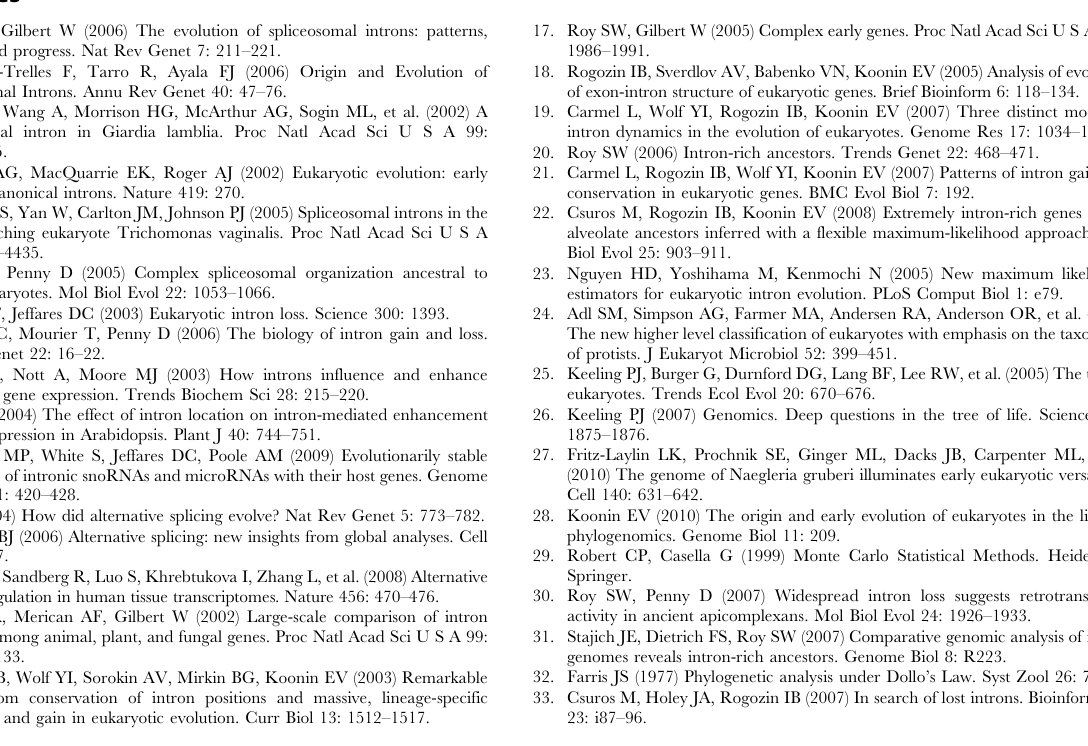
Figure S1 Posterior distributions of the ancestral intron densities inferred from the sampling chains for all ancestral forms. Text S1 Detailed methods and results with the illustrating figures and tables. Video S1 Dynamic representations of the histories of intron